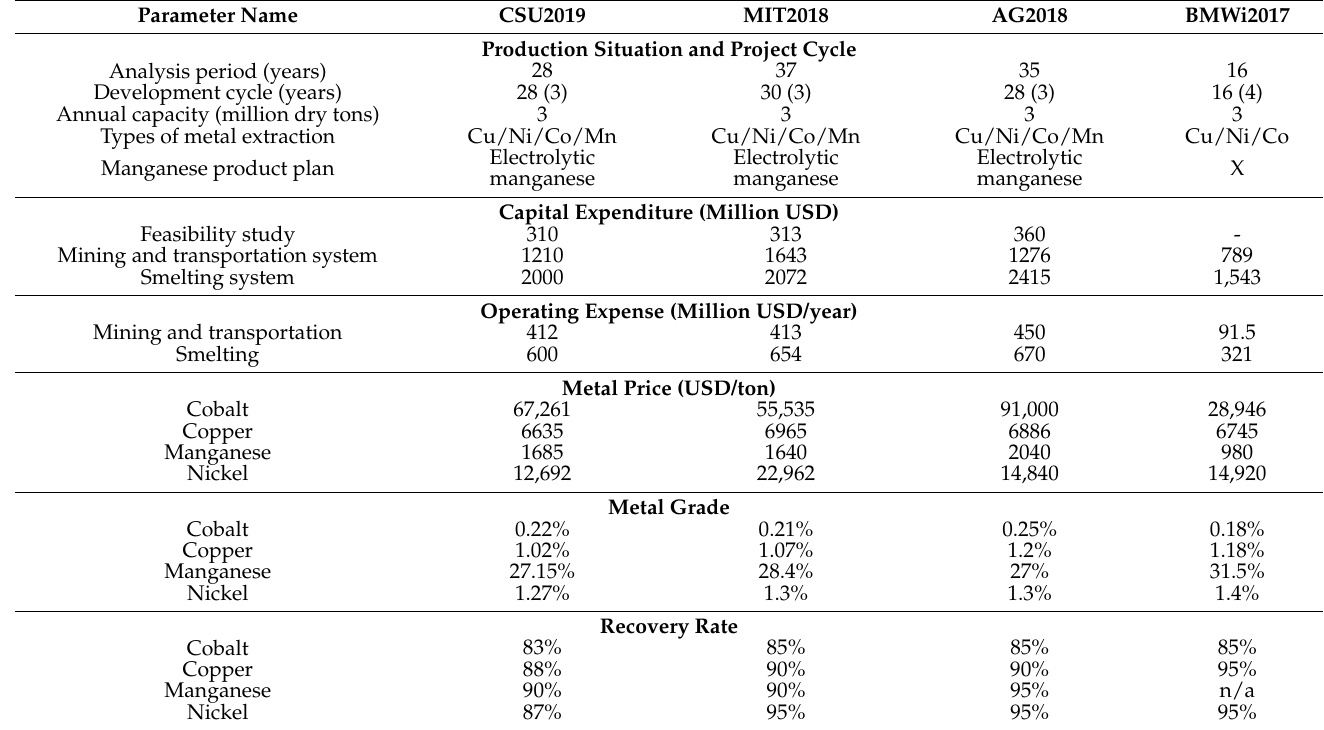
Table 6. Main cost and price parameters of each financial